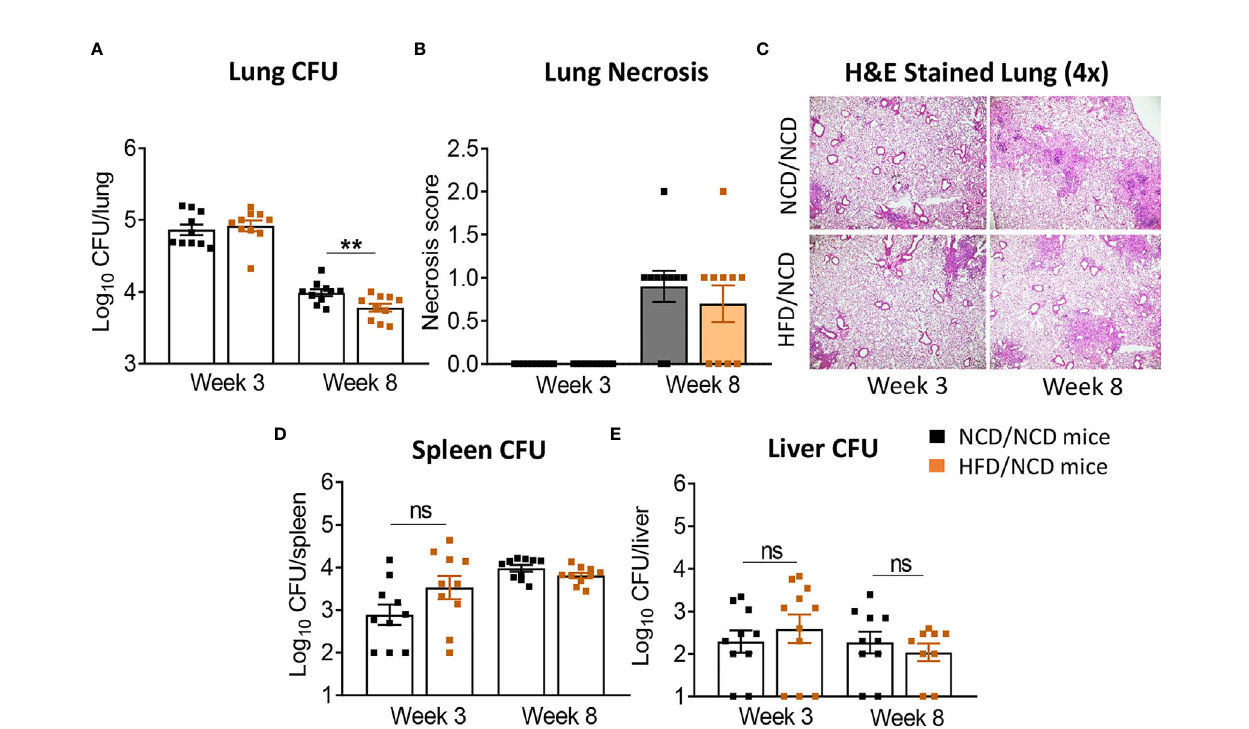
FIGURE 6 | Restoration of glucose tolerance with elevated fat mass confers mild resistance to TB. (A) Lung Mtb burden in NCD/NCD- (black) and HFD/ NCD mice (orange) at 3- and 8-weeks p.i.; (B) Lung Necrosis scores; (C) Representative lung histological images; (D) Mtb burden in spleen and (E) in liver. Data are means ± SEM (n=10 mice/group analyzed in one independent experiment). Data analysis was performed by Mann-Whitney U test. ns = not signi fi cant. **p <